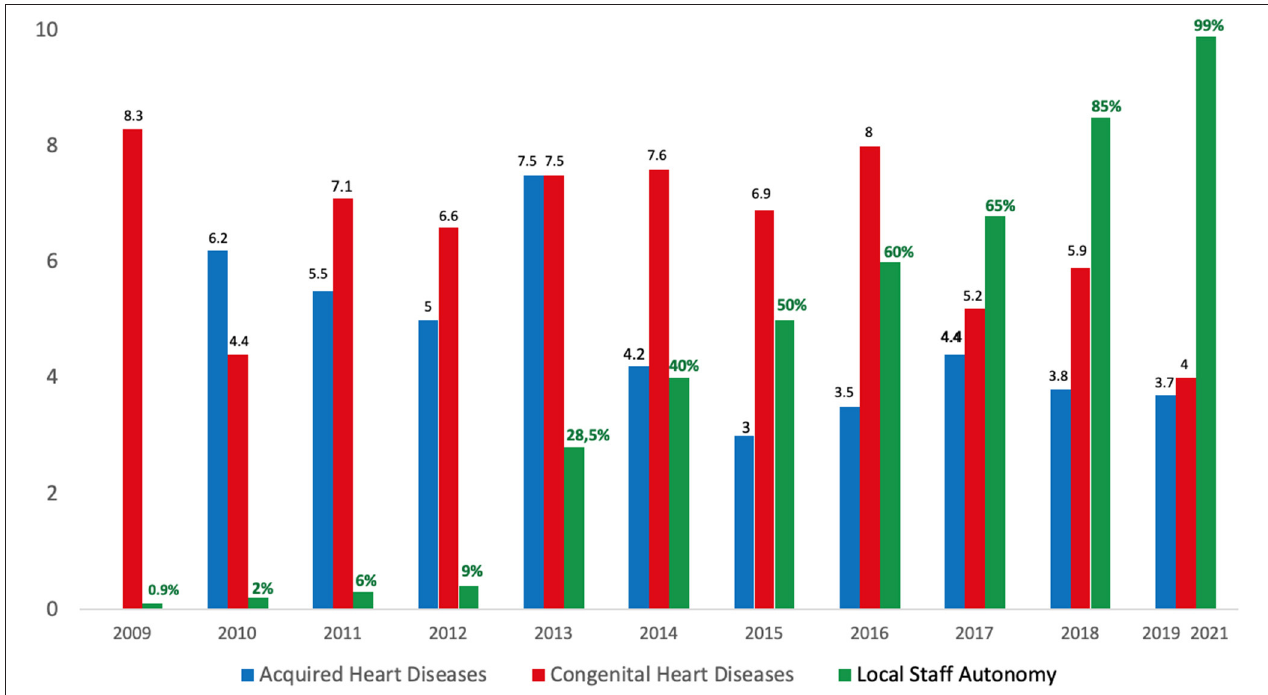
FIGURE 3 | The bar graph shows the hospital mortality (%) rate after surgery for acquired heart disease (blue bar) and congenital heart disease (red bar). The green bar shows the rate of local staff surgical